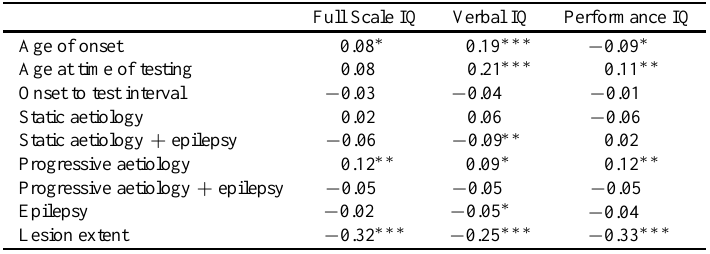
Table 4 Correlations between various “clinical” variables and Verbal IQ, Performance IQ and